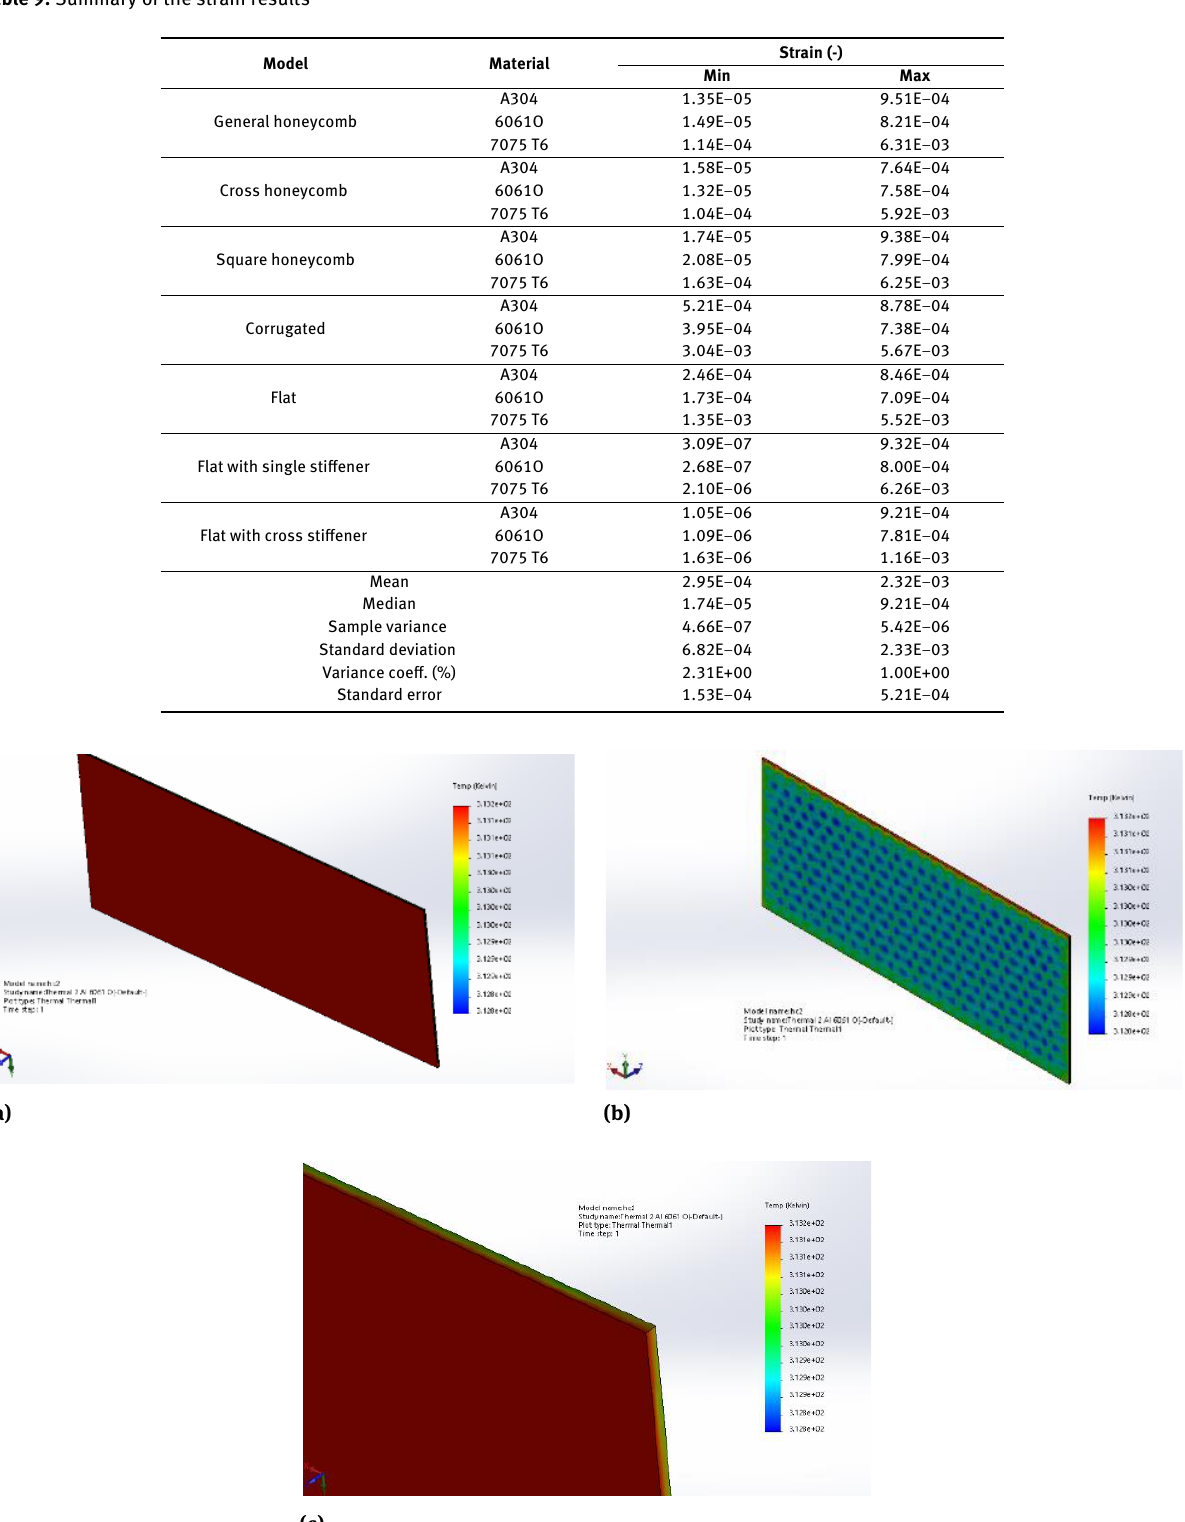
Table 9: Summary of the strain results